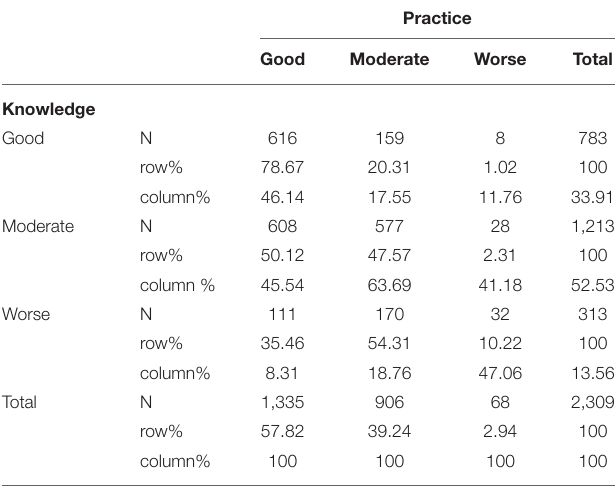
TABLE 4 | Cross-table of knowledge and practice of COVID-19 prevention measures ( N = 2,309).